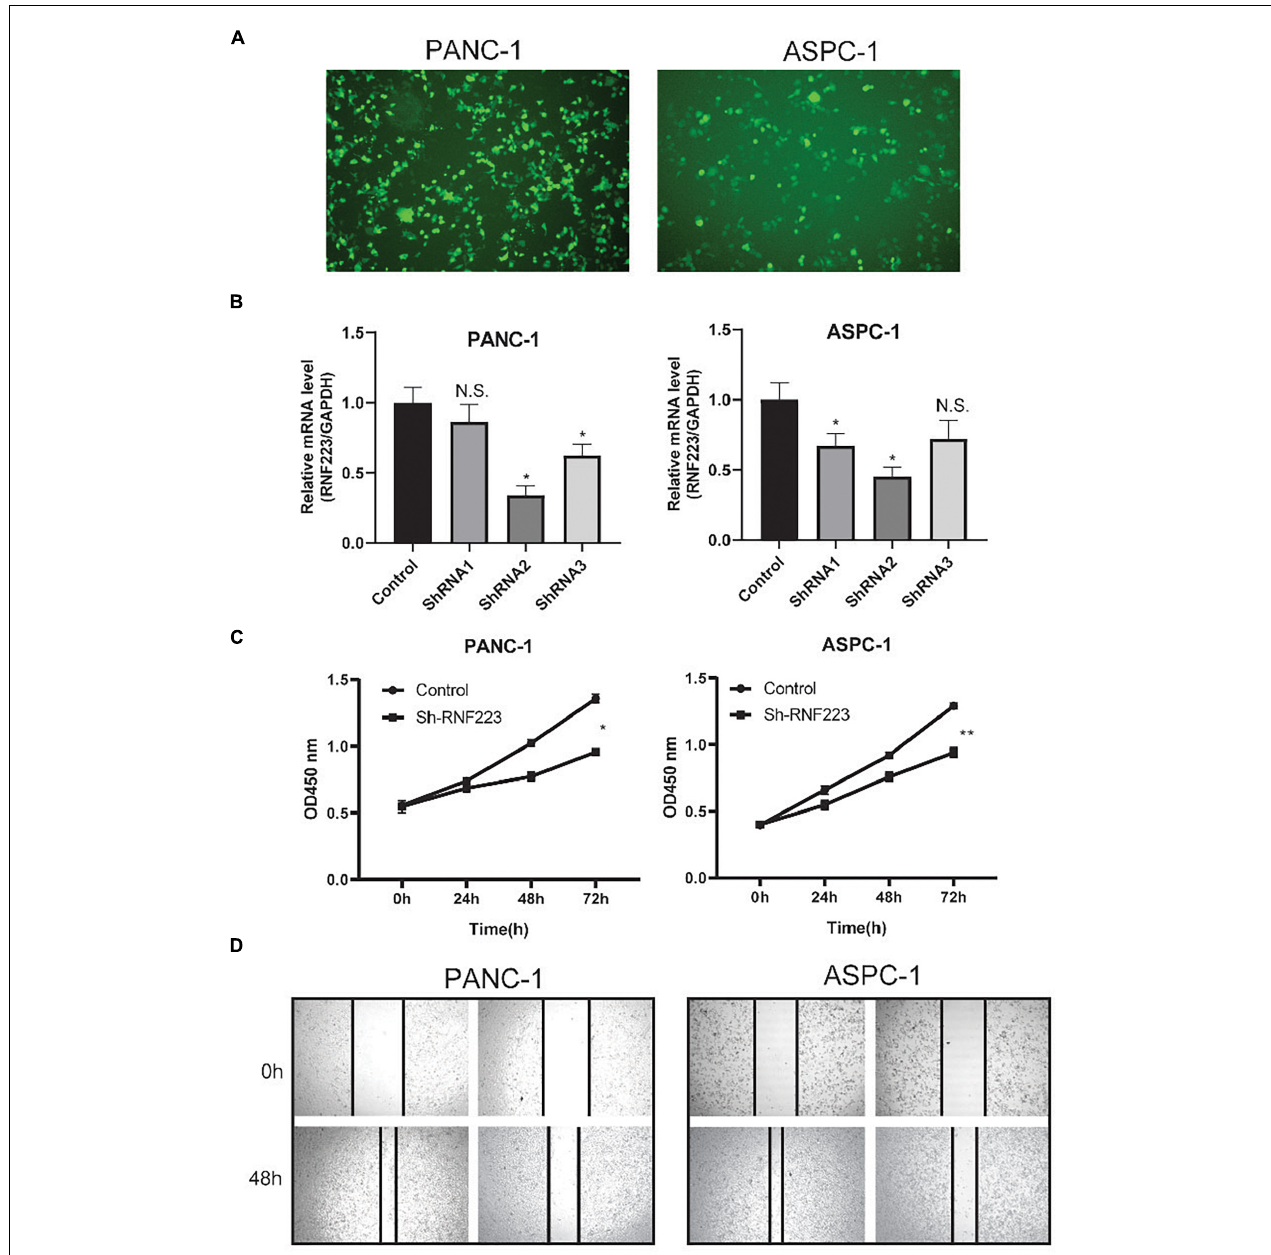
FIGURE 5 | Functional investigation of RNF223 silencing in pancreatic cancer PANC-1 and ASPC-1 cell lines. (A) Representative cell morphology of transfection efficiency of RNF223 shRNAs in pancreatic cancer cells. (B) The silencing efficacy of three shRNAs was examined using qRT-PCR in pancreatic cancer PANC-1 and ASPC-1 cell lines. (C) The CCK8 assay was conducted to analyze the effect of RNF223 knockdown on the proliferation capability of pancreatic cancer PANC-1 and ASPC-1 cell lines. (D) The wound healing assay was conducted to analyze the effect of RNF223 knockdown on the migration capability of pancreatic cancer PANC-1 and ASPC-1 cell lines. All assays were conducted using three replicates and * p < 0.05, ** p <